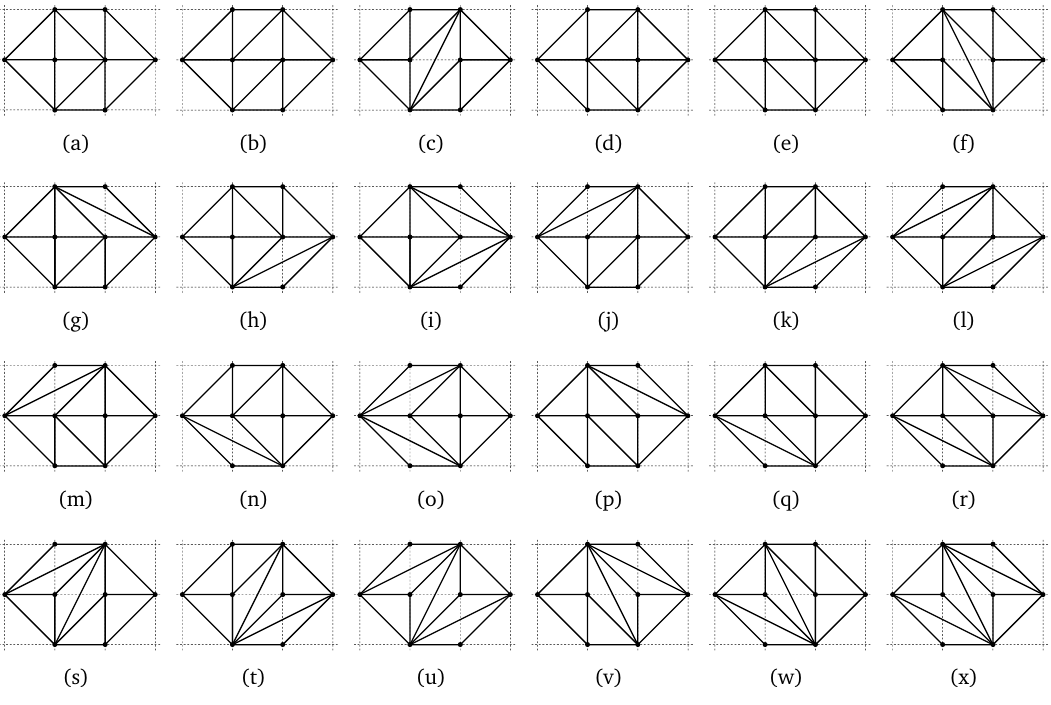
Figure 17: All 24 resolutions of the beetle geometry. The 6 resolutions (a)-(f) admit a vertical projection, the 16 resolutions (a), (b), (d), (e) and (g)-(r) admit a horizontal projection. Note that the 4 resolutions (a), (b), (d) and (e) admit both. The last 6 resolutions, (s)-(x), admit neither, hence do not have a gauge theory